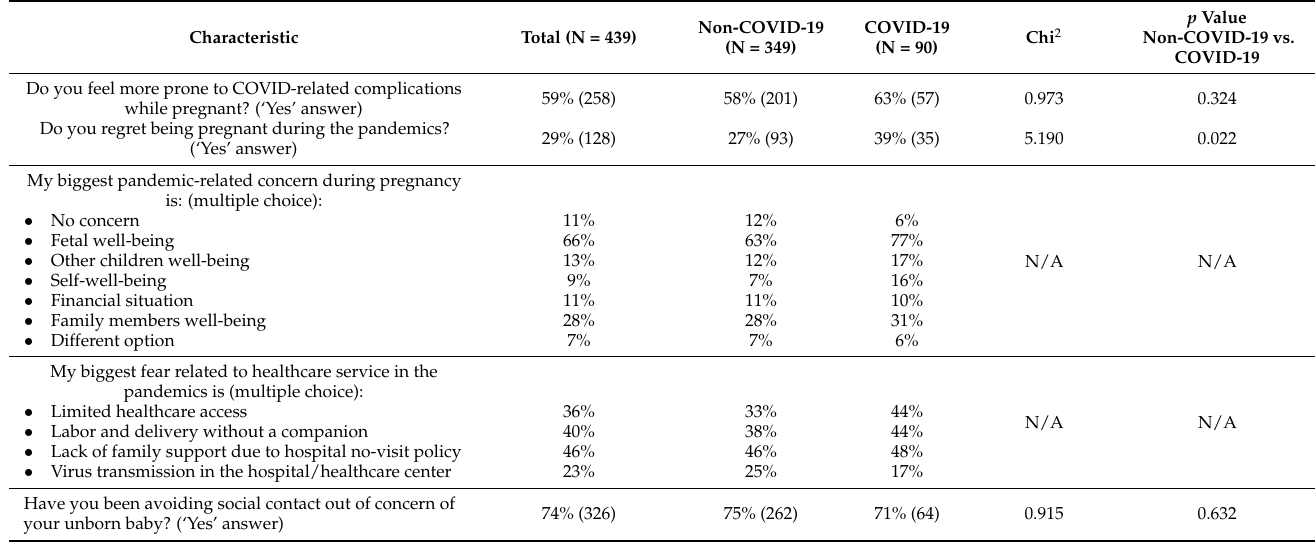
Table 4. Pregnancy-related